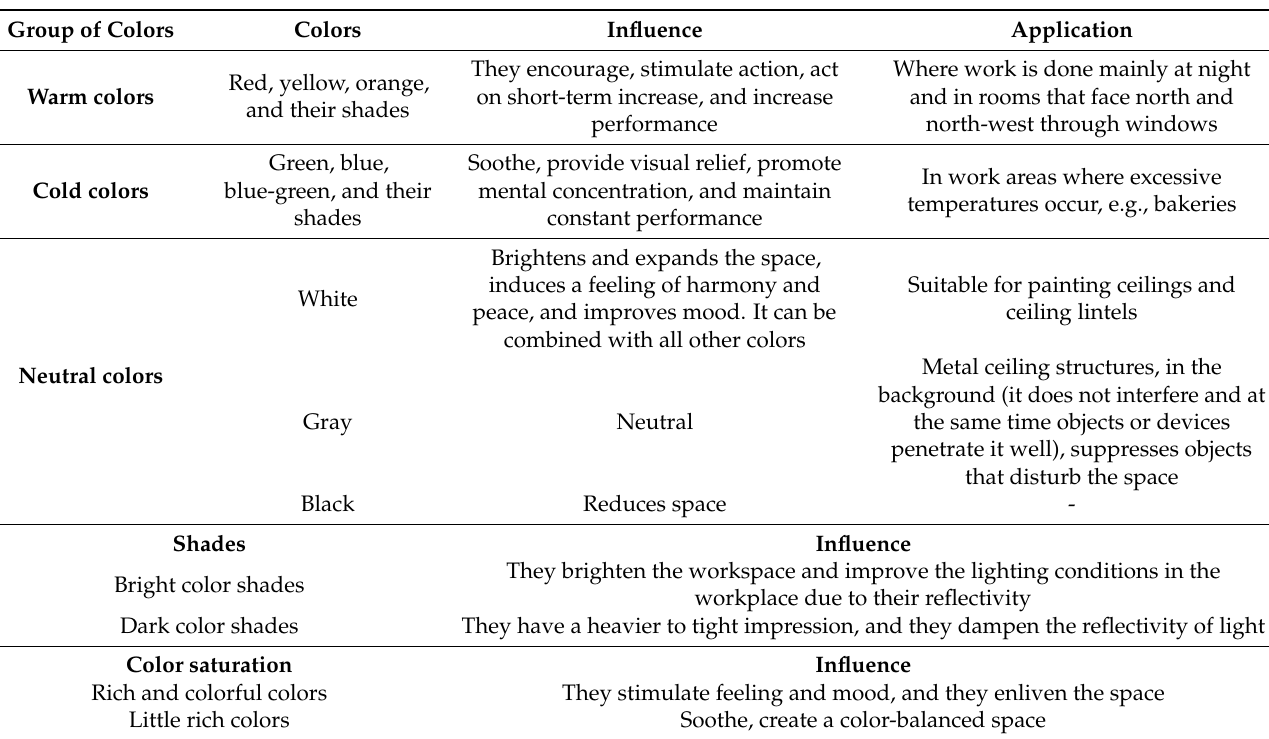
Table 1. Psychophysiological effect of colors.